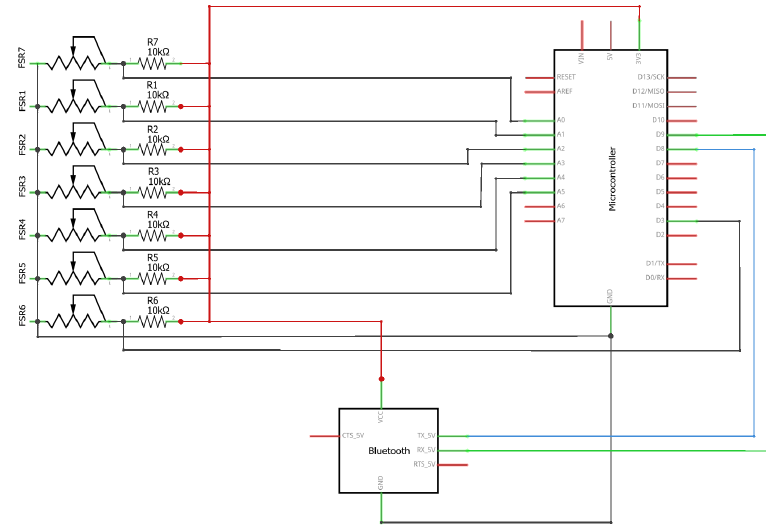
Figure 4. Connections